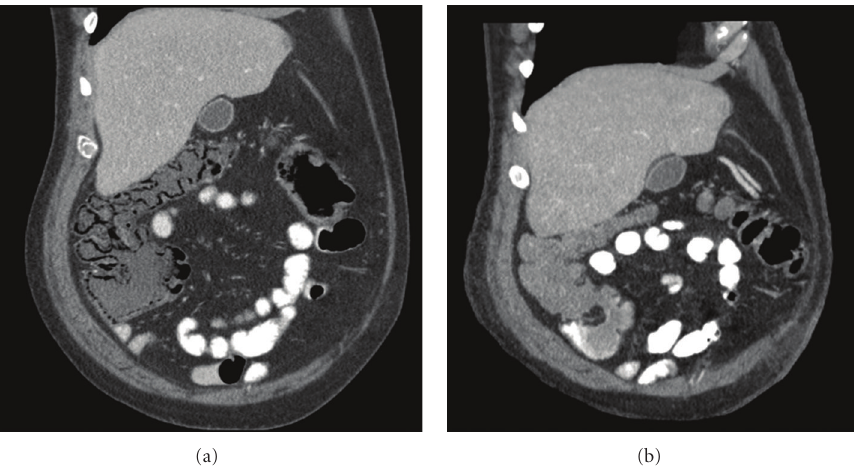
Figure 1: (a) CT scan of the abdomen 2 days following high-dose intravenous steroids shows extensive PI of right colon. Intramural gas tracking is visualized parallel to the bowel mucosa in the ascending and transverse colon. (b) Repeat CT scan after 3 days bowel rest and tapering of steroids and shows resolution of PI. No evidence of intramural gas along the colonic mucosa is